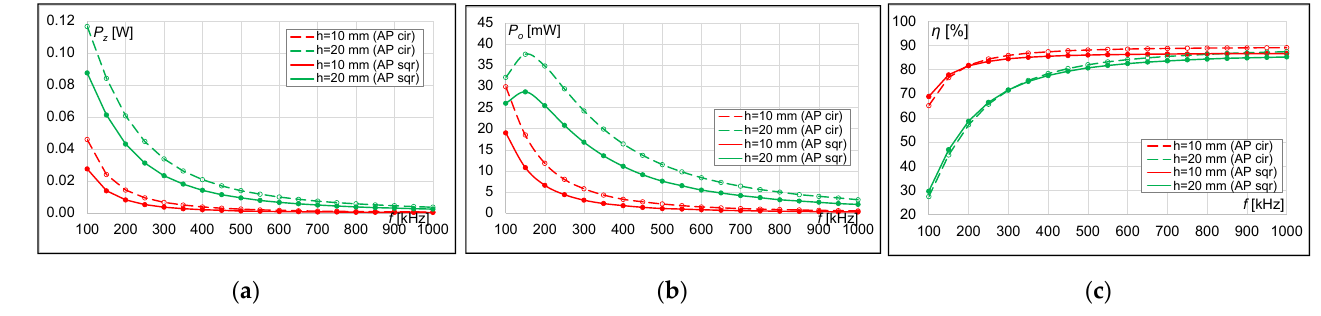
Figure 29. Results for the aperiodic system with circular or square coils with r = 20 mm and the number of turns n = 60 at two distances ( h = 10 mm and h = 20 mm): ( a ) transmitter power, ( b ) receiver power, ( c ) power transfer efficiency.